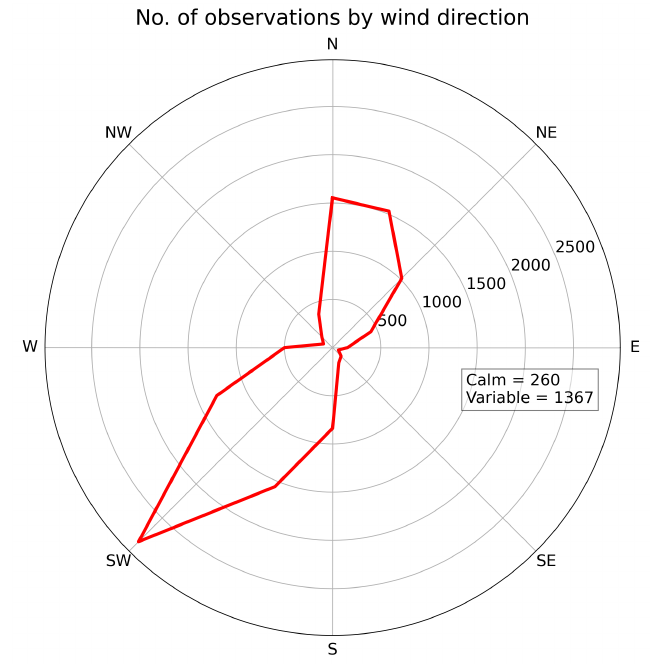
Figure 5. Number of observations by wind